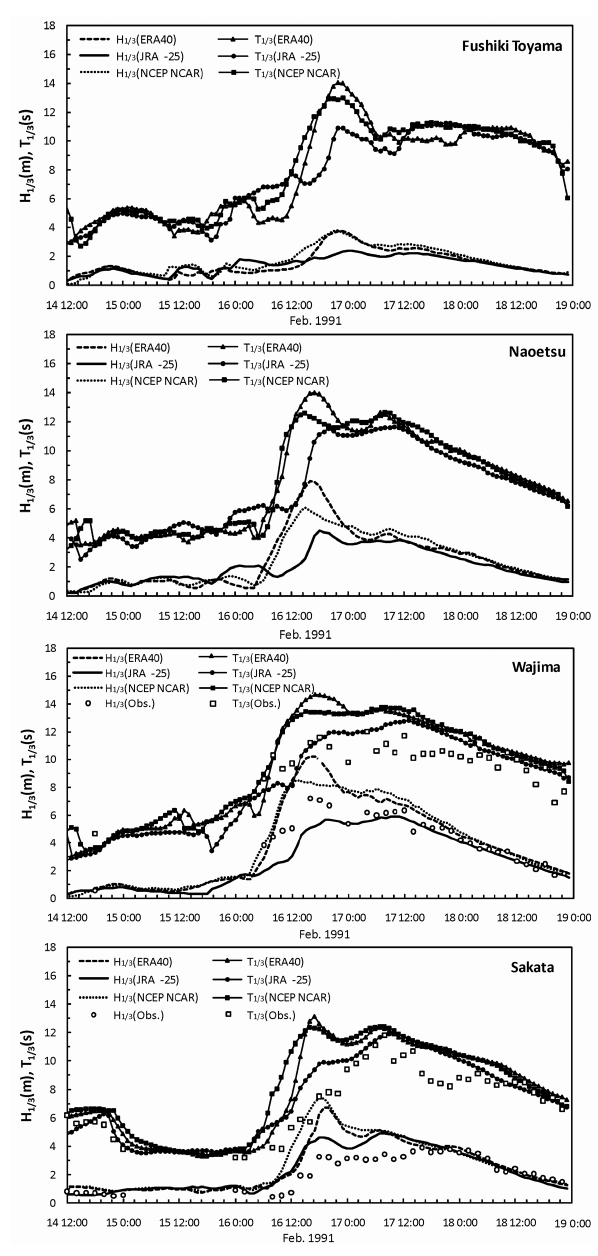
Fig. 10. Comparisons of observations and calculations of wave characteristics at Fushiki Toyama, Naoetsu, Wajima, and Sakata in Japan for the event of February 1991. The observations were available only from Wajima and